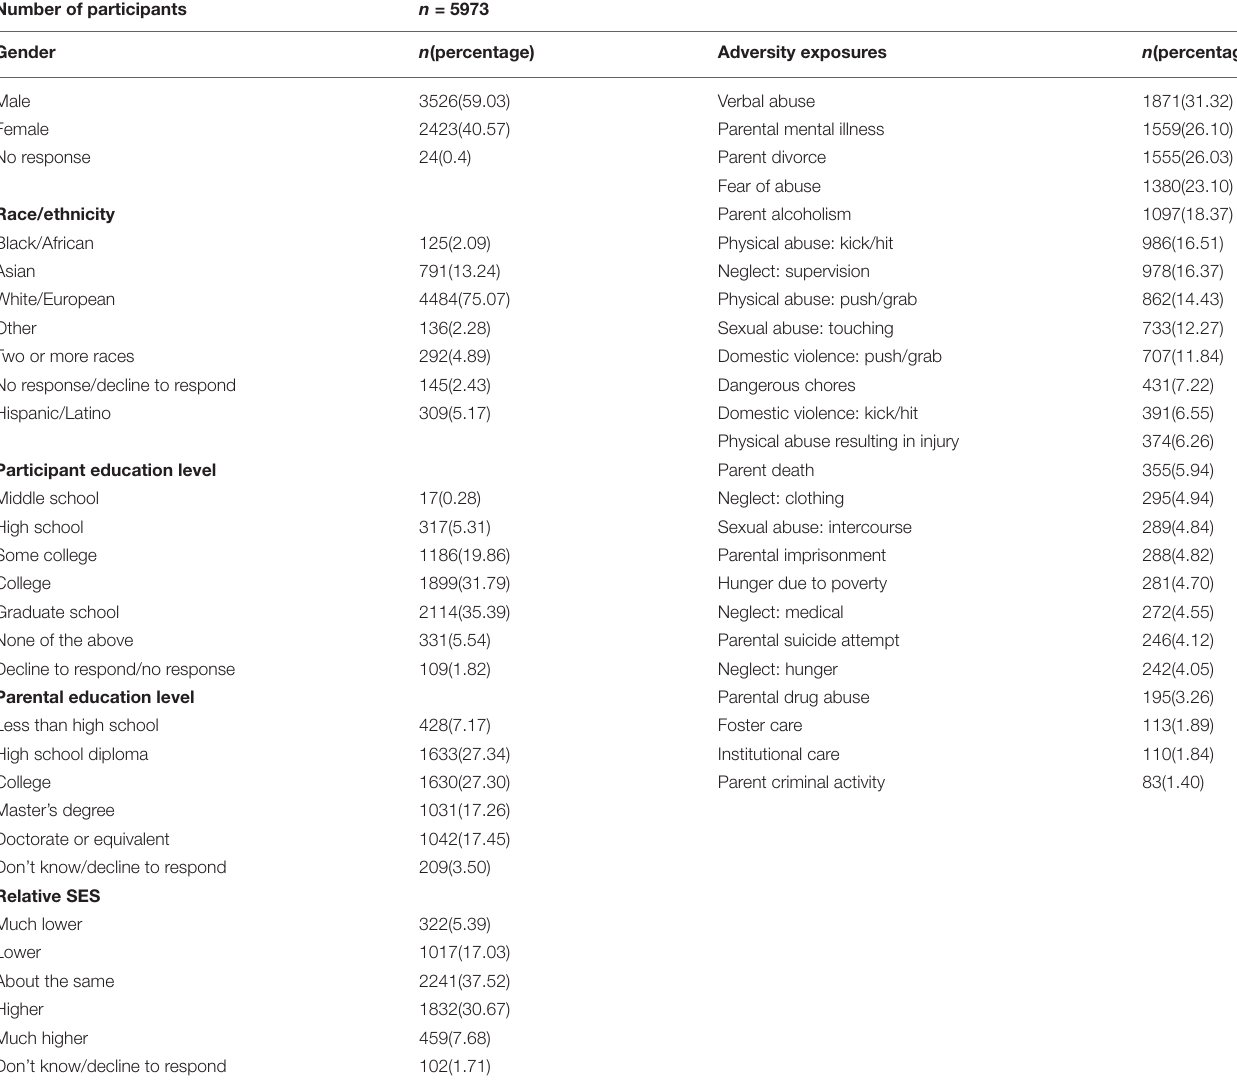
TABLE 1 | Demographic characteristics and adversity exposure rates in our analytic